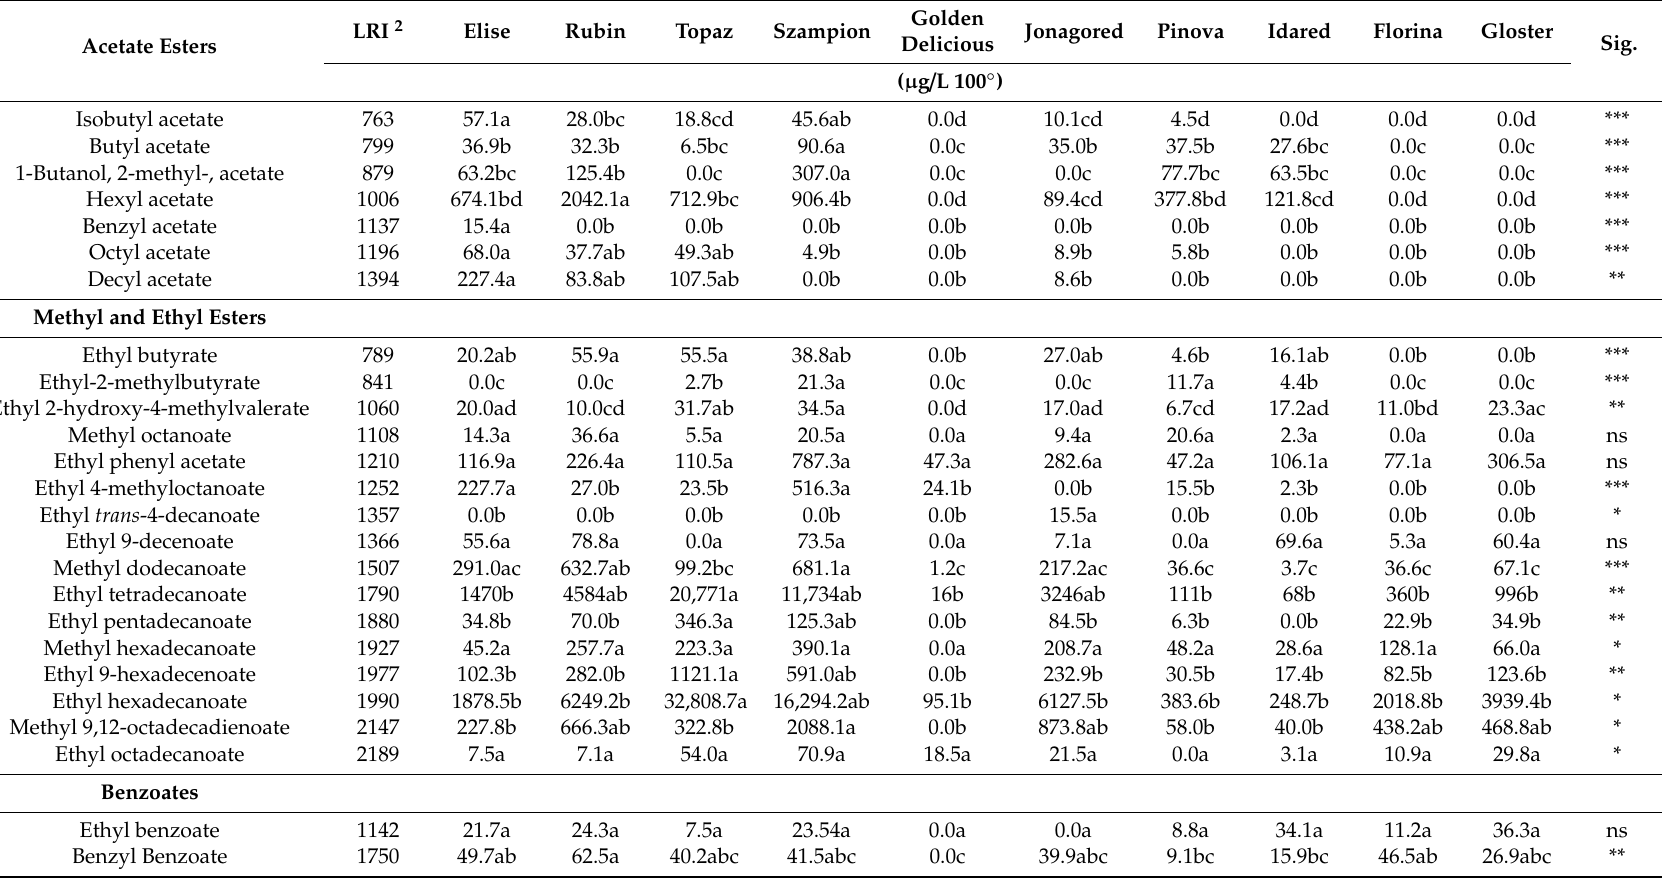
Table 4. Aroma composition of apple spirits produced from di ff erent apple cultivars (solid-phase microextraction- gas chromatography-mass spectrometry (SPME-GC-MS) ( µ g / L 100 ◦ ).